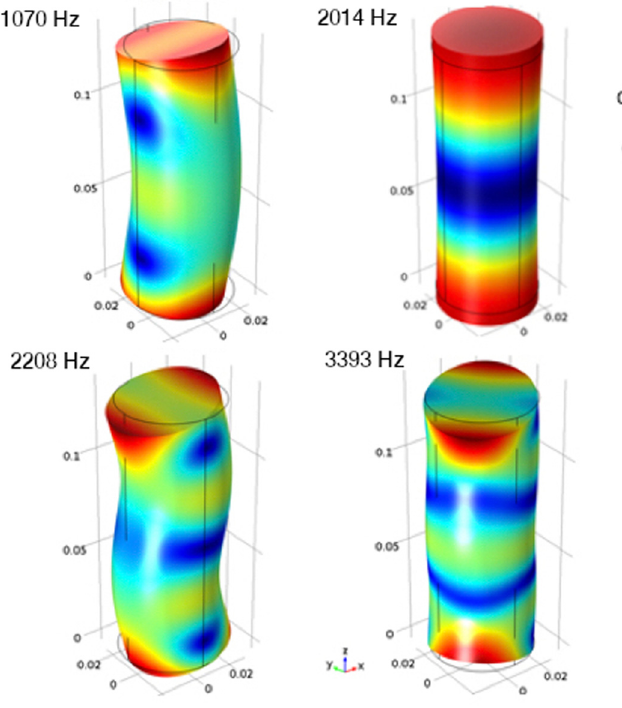
Figure 17: Simulated natural frequencies for sample in sleeve. Sample body 130.7 and sleeve 170